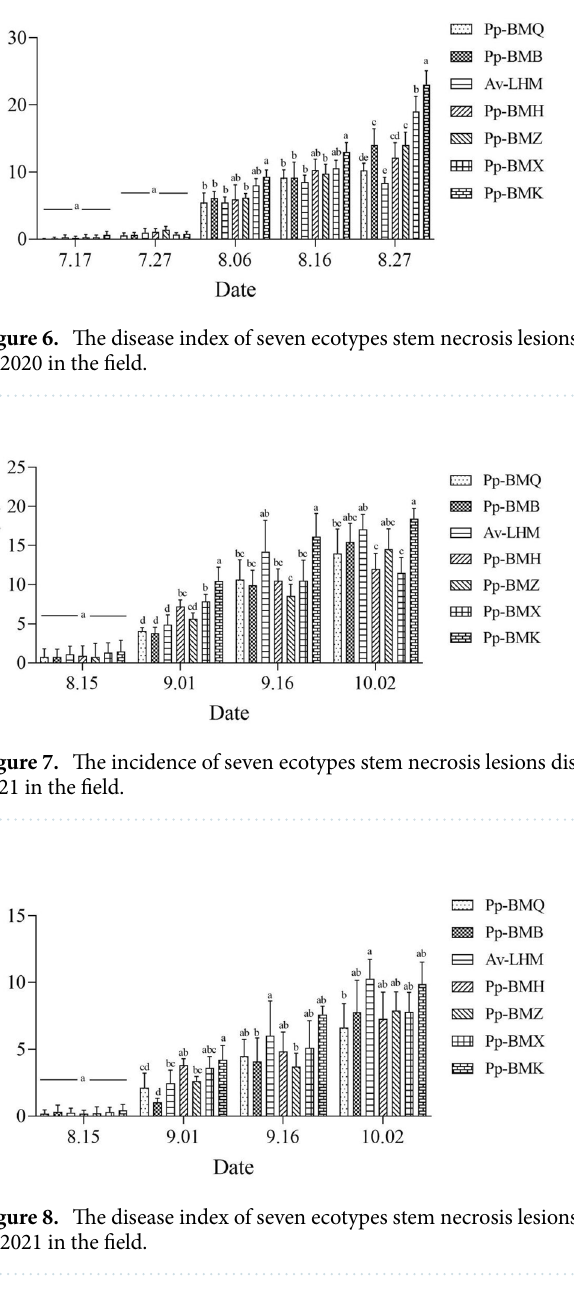
(Fig. 10c,d), while the leaves of A. venetum and P. pictum had unclear concentric rings (Fig. 10e). No symptoms were observed on the corresponding controls. Furthermore, the pathogen was re-isolated from the symptomatic leaves, and their identification was confirmed by morphology and molecular analysis. The pathogenicity analysis showed that under greenhouse conditions, B. exigua var. rhapontica could infect Luobuam leaves and induce slightly different symptoms for 8 ecotypes of the three species of Luobuma. The leaf incidence of the eight ecotypes was investigated in triplicate from late September to early October under greenhouse conditions. The collected data showed that ecotype Pp-BMK was the highest incidence rate on Sept. 20 and Sept. 28 (8.34% and 10.42%, respectively), while the ecotype Pp-BMH had the lowest incidence rate (2.78% and 2.78%, respectively) (Fig. 11; P < 0.05). However, 21 days after inoculation, the incidence rate of ecotype Av-LHM was the largest (15.97%), while that of Pp-BMH was the lowest (4.86%). Pathogenicity on the stem tissues. To confirm Koch’s postulates, we inoculated the two strains (AvLM- Be and Av-Be) on the stem of the eight ecotypes. After 5 days, the stems of all inoculated ecotypes developed necrosis lesions, which had brown spots with wedge-shaped indentations at the beginning (Fig. 12a). However, 13 days after inoculation, the symptomatic stems and shoots withered and died (Fig. 12b–d). There were no dif- ferences in lesion shape on the stems of the eight ecotypes; however, the degree of necrosis lesion spots and the